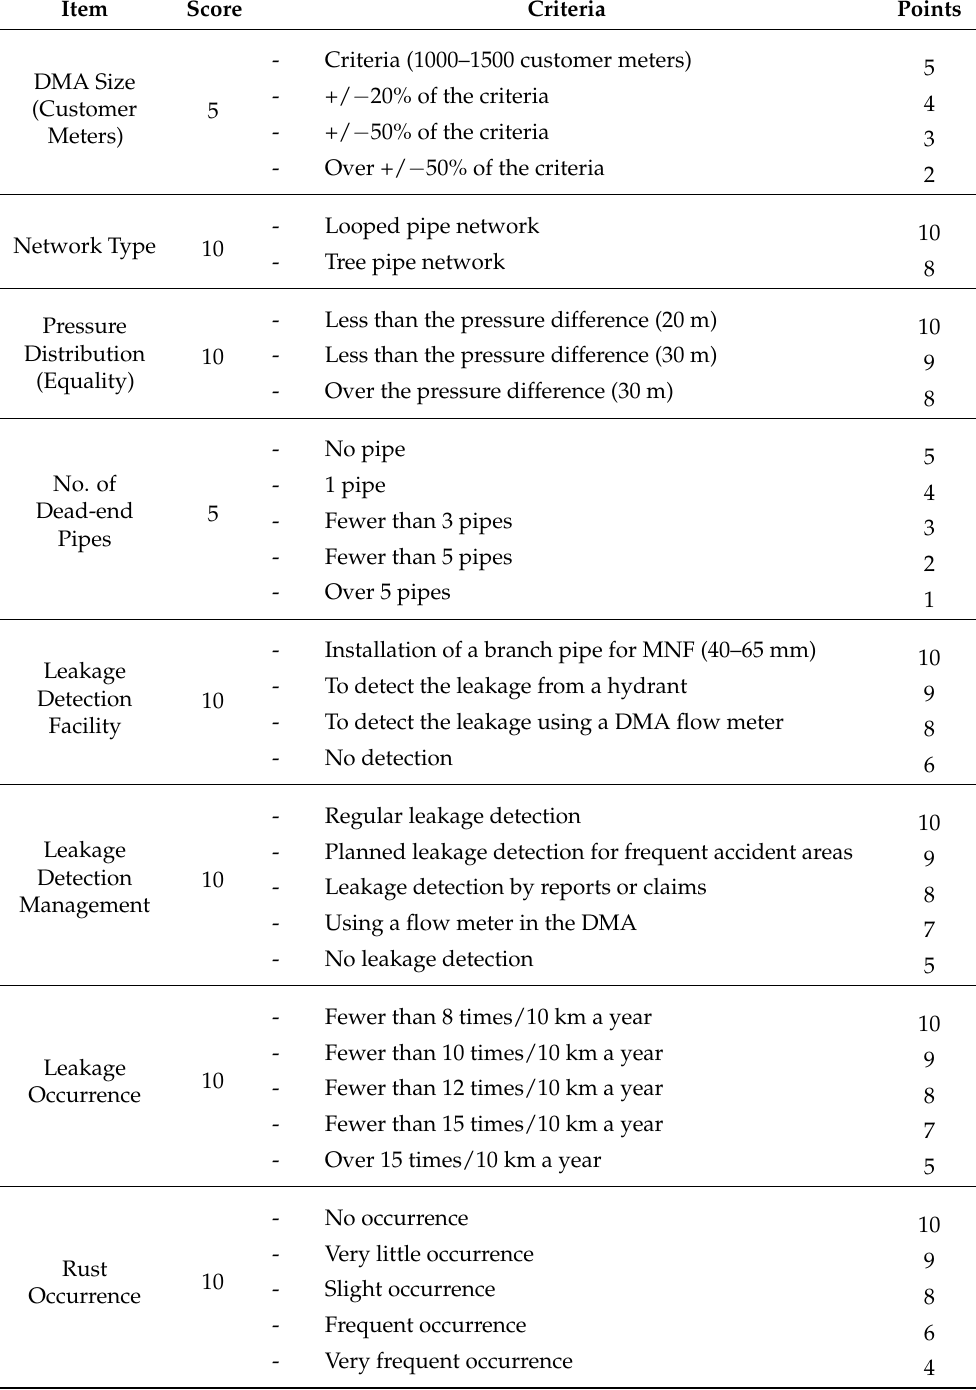
Table 1. DMA evaluation